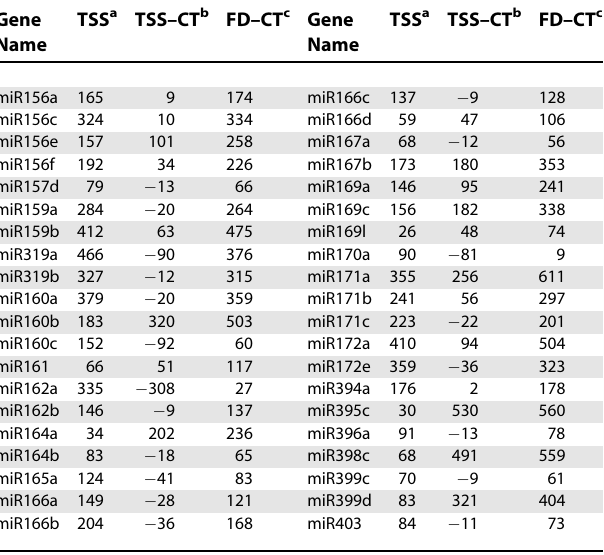
Table 8. The Distances between CT Repeats and TSSs in the Promoters of 40 of 52 A. thaliana MicroRNA Genes Analyzed by Xie et al. [22]